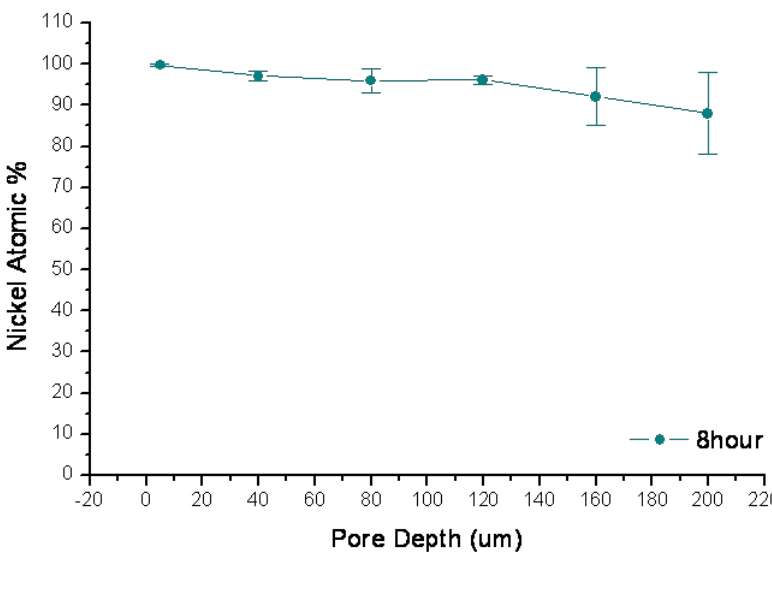
Figure 5. Plots of Ni atomic percentage profile measured by EDX along the pore depth for 8 hours